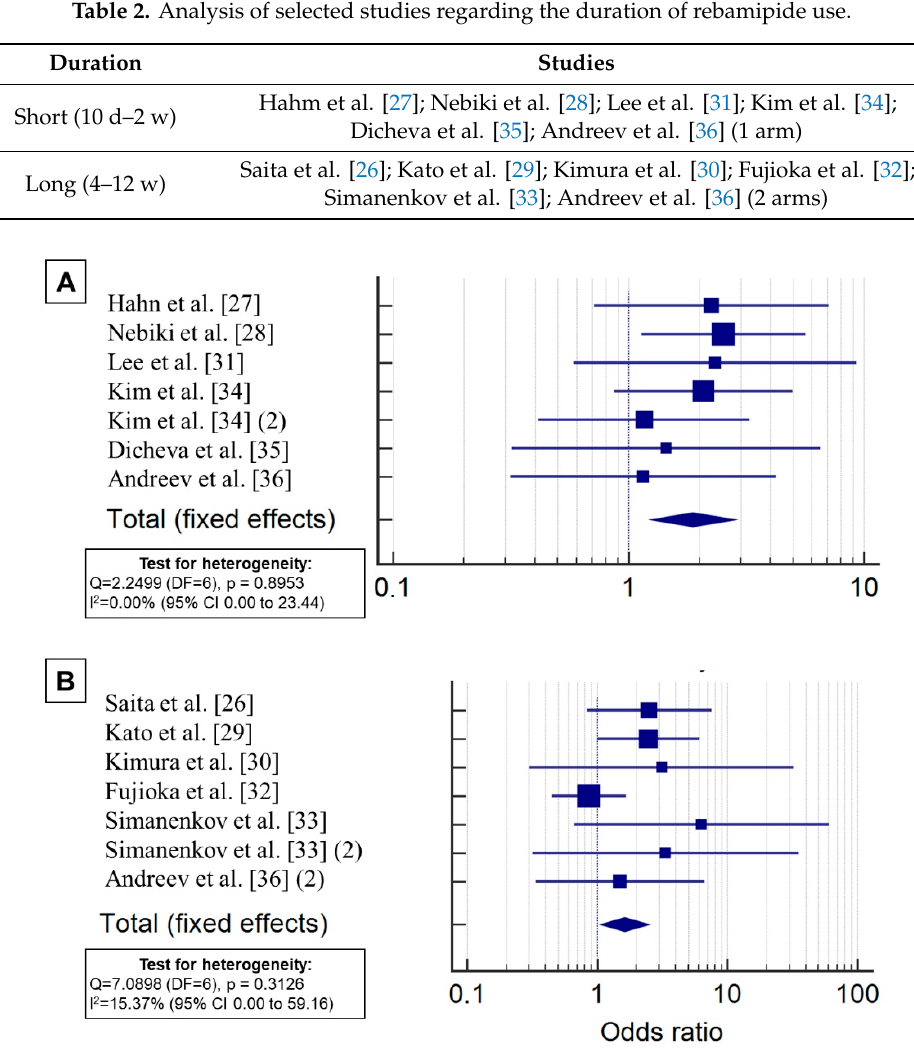
Figure 3. Forest plot showing the odds rations (ORs) and 95% CIs for the effectiveness of the inclusion Figure 5. Subgroup analysis of the e ff ect of rebamipide on the e ffi cacy of eradication therapy for of rebamipide in the eradication treatment regimen for Helicobacter pylori infection. H. pylori infection with short ( A ) and long ( B ) courses of